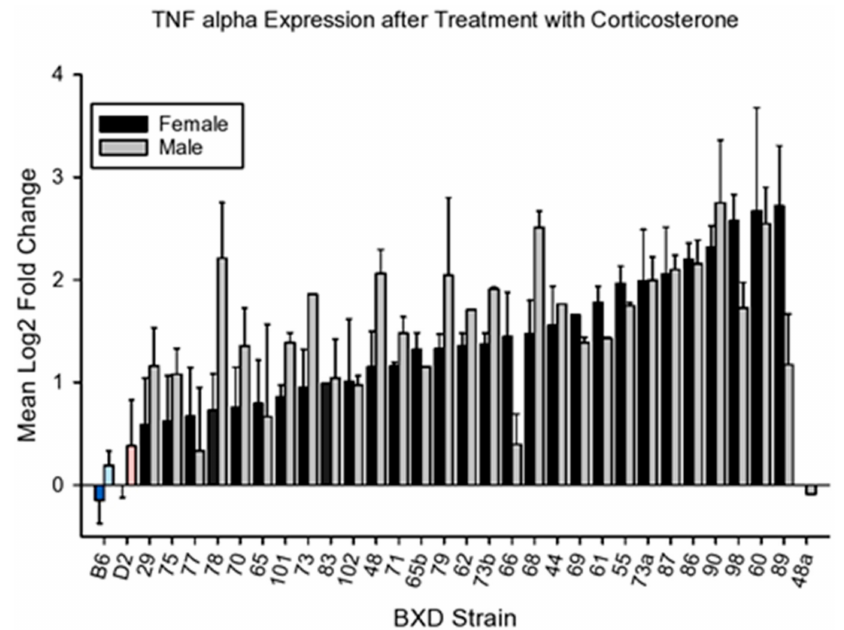
Figure 6. Mean change ( ± s.e.m) vs. control in Tnfa expression in prefrontal cortex following 7 days of corticosterone in the drinking water and 6h following intraperitoneal injection with normal saline. ANOVA revealed a significant main e ff ect for strain (F 32,111 = 5.31, p < 0.01). E ff ects for sex or strain X sex interaction were not significant (F 1,111 = 1.83, p < 0.20; F 30,111 = 1.98, p < 0.35). DFP and DFP + CORT also a ff ected Tnfa expression in prefrontal cortex (Figure 7). Analysis